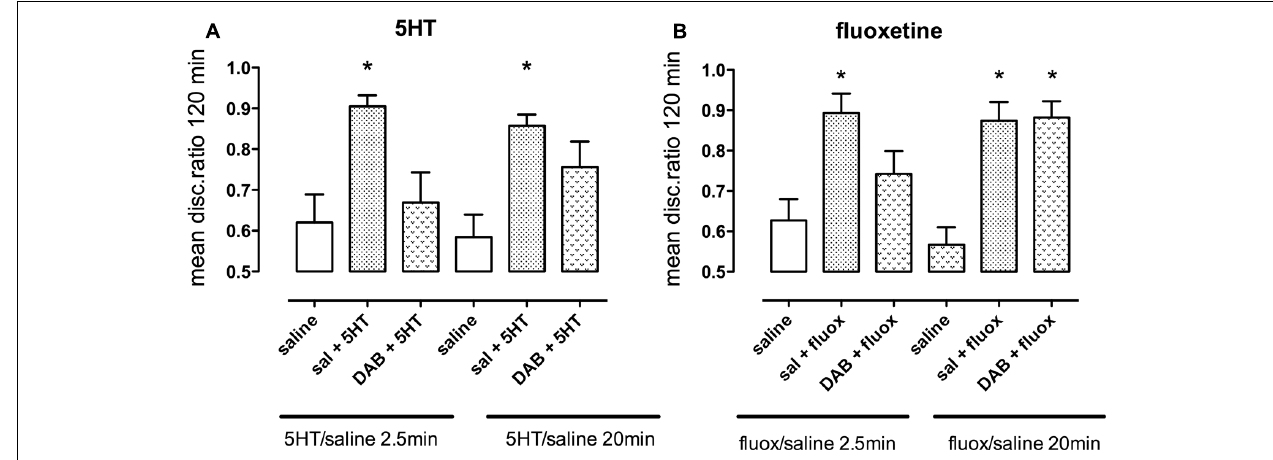
training and serotonin 20 min after training. (B) Enhancement of weakly reinforced training by fluoxetine was only prevented by DAB at the early period and not the later (intermediate) one at 20 min, n = 12–20 per group, * P < 0.05 from animals injected with saline at the same